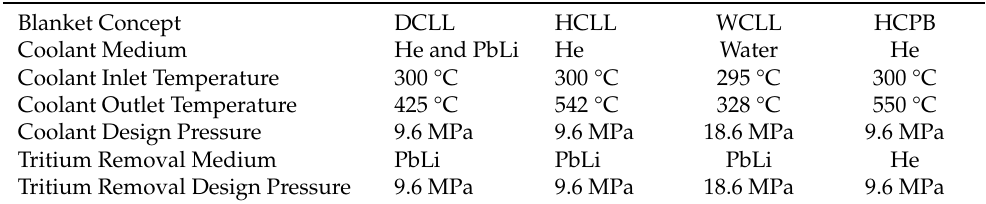
Table 1. Comparison between multiple breeding blanket-cooling concepts